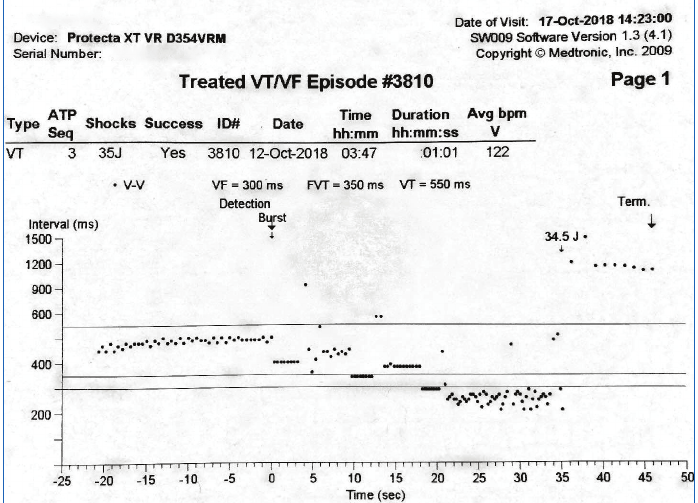
Figure 3: De-Identified printout from a patient’s ICD showing an episode of V-Tach with attempted anti-tachy pacing (ATP) followed by successful 34.5 J defibrillation. Image supplied by Medtronic